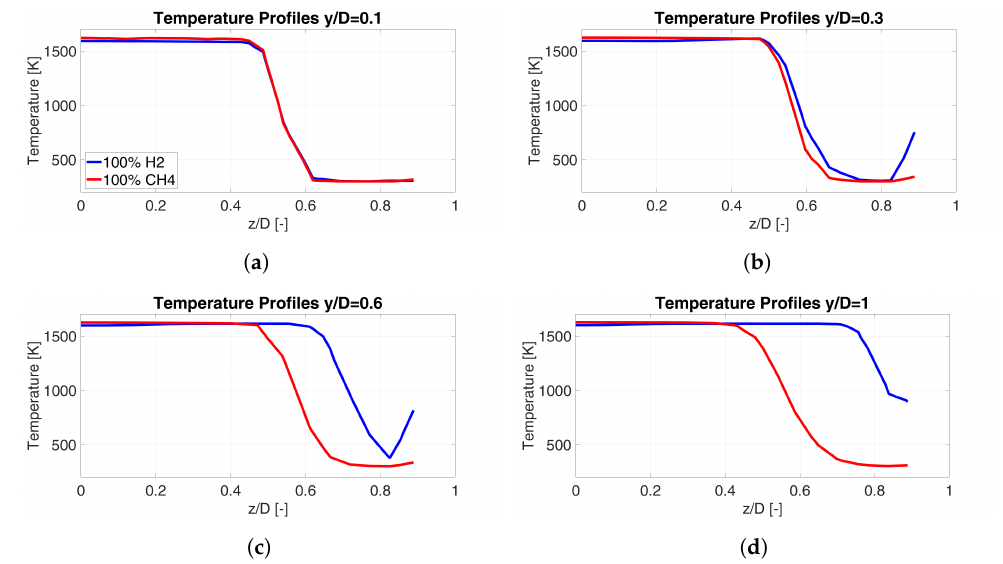
Figure 14. Comparison between the temperature profiles for the two different mixtures at different axial positions (( a ) y / D = 0.1, ( b ) y / D = 0.3, ( c ) y / D = 0.6, ( d ) y / D = 1).